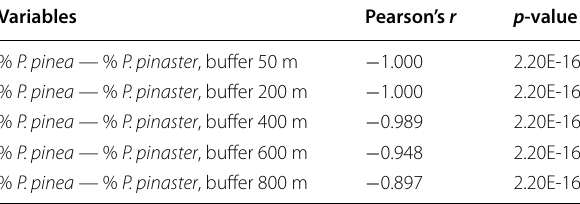
Table 2 Pearson’s correlation coefficients and the associated P ‑value of the t ‑test for the relationship between the % P. pinea and the % P. pinaster at different buffer sizes around the traps